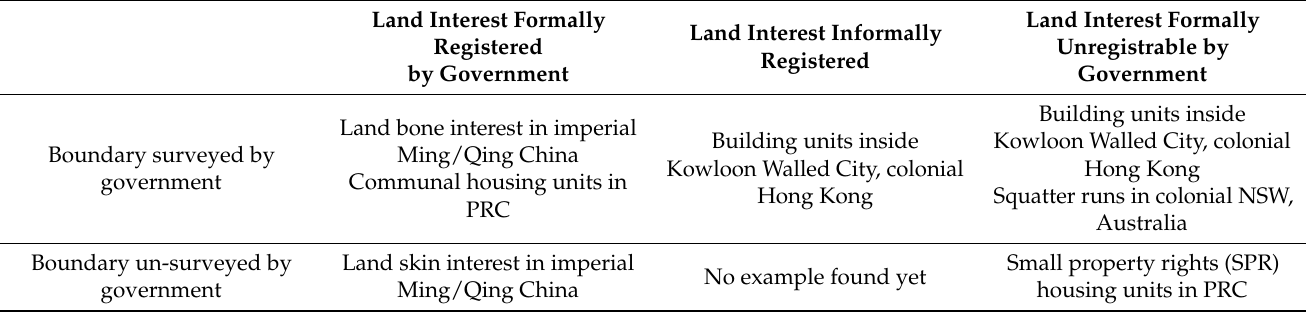
Table 1. A taxonomy of examples studied by mode of land interest registration and government boundary